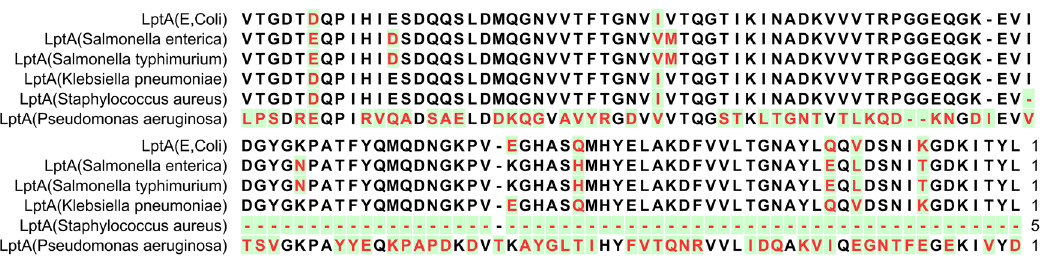
Figure 2. The alignment of LptA amino acid sequence of different pathogens from MIC test.